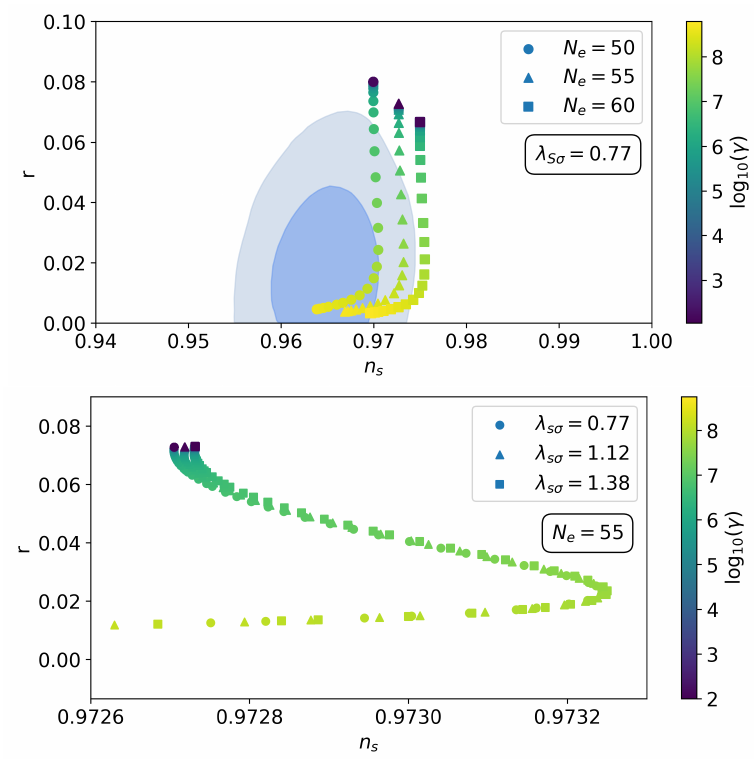
Figure 2 . Predictions for the scalar spectral index n s and the tensor-to-scalar ratio r with varying number of e-folds N e (top) and varying λ Sσ (bottom). For all points we have fixed β σ = 1 and λ S = 0 . 005 . Only points which satisfy the scalar power spectrum A s constraint (4.24) are displayed i.e. the β S dependence is fixed in light of figure 1. In the top panel we included the Planck TT,TE,EE+lowE+lensing+BK15 68% and 95% CL regions taken from ref.